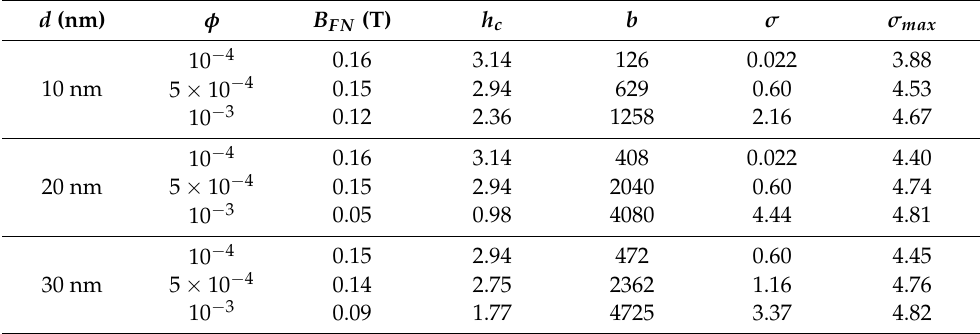
Figure 6. Dependencies of dimensionless field h c on the diemnsionless coupling energy σ for composites with ( a ) 10 nm ( b ) 20 nm ( c ) 30 nm particles. Table 2. Table of parameters—volume concentration φ , threshold magnetic field B FN , dimensionless threshold field h c , dimensionless parameter b , and the dimensionless coupling energy σ and its maximum value σ max